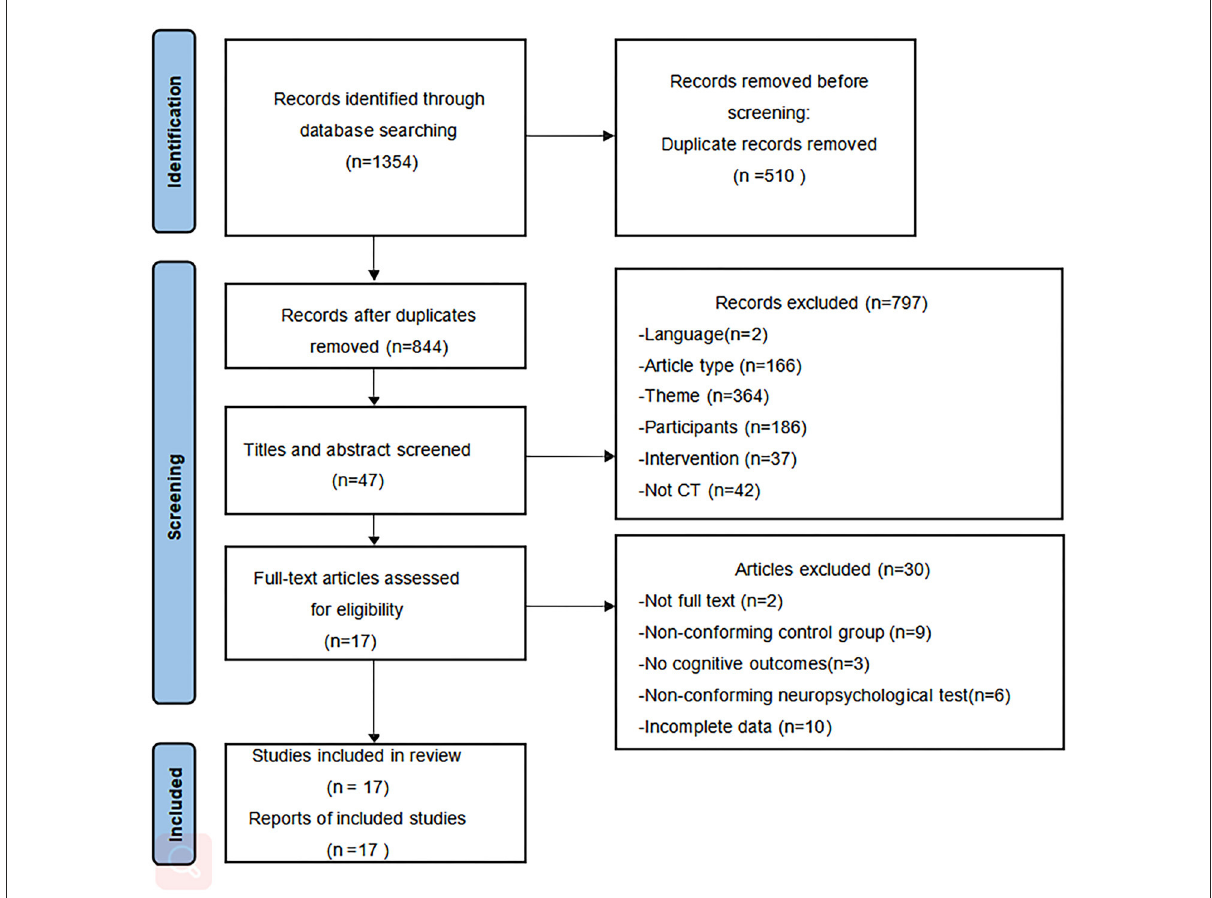
FIGURE1 PRISMA flowchart of study